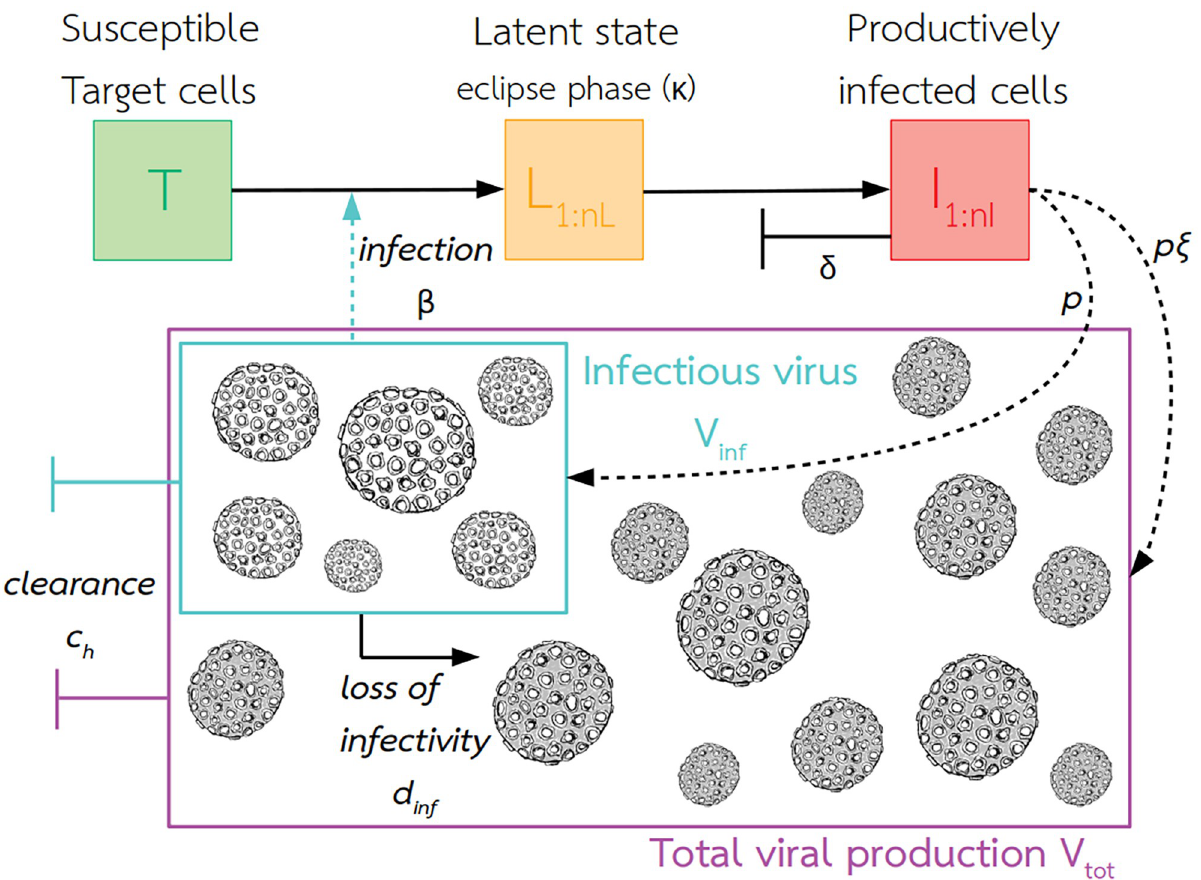
Fig 1. Graphical representation of the within-host model. Infectious viruses V RT-qPCR measures. The eclipse phase (state L ) is the period between the infection of a cell by a virus and the presence of mature viruses within the cell. Productively infected cells I are the only ones producing progeny virions. Subscripts in L and I indicate the use of Erlang distributions for the time spent in those states. Target cells are not replenished and only productively infected cells die. Model assumptions, equations and parameter definitions can be found in Materials and methods, Eq (1), and Table